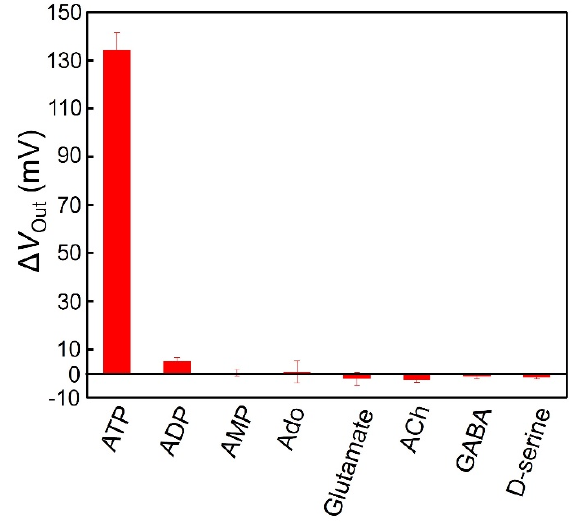
Figure 12. The selectivity of ATP detection. The concentration of ATP and other chemical substances is 100 µ M. All experiments were performed in 10 mM − HEPES at pH 7.4. An error bar shows the standard deviation ( n = 3).